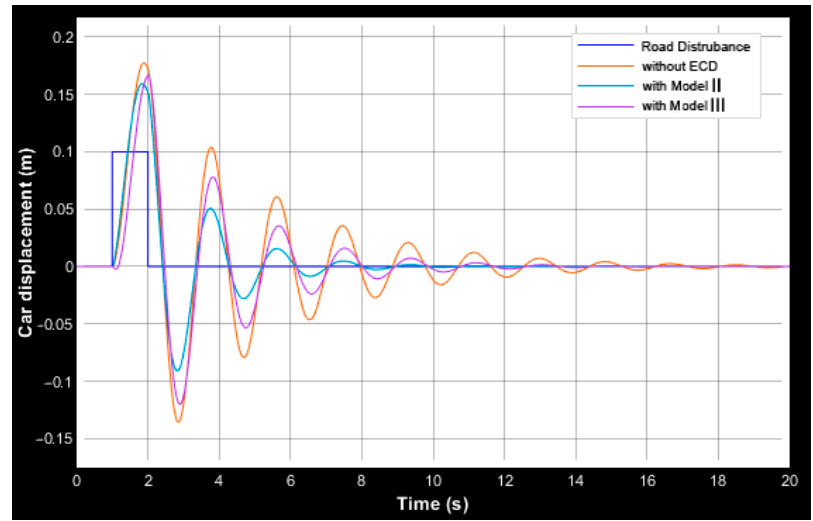
Figure 10. Comparison between the suspension displacement response during road disturbance, between Models II and III.